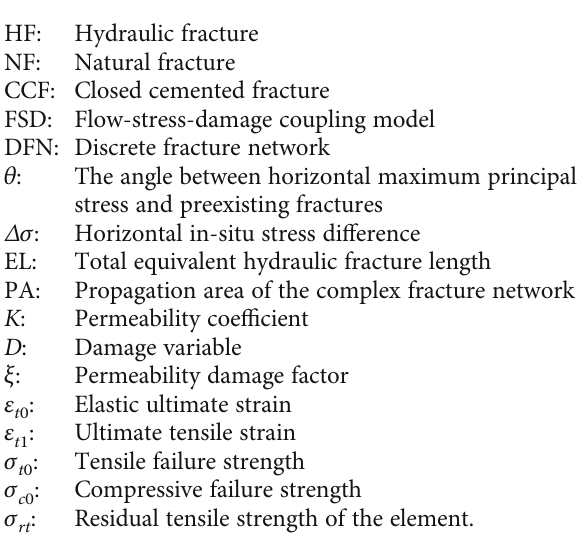
e ff ective propagation length of hydraulic fracture